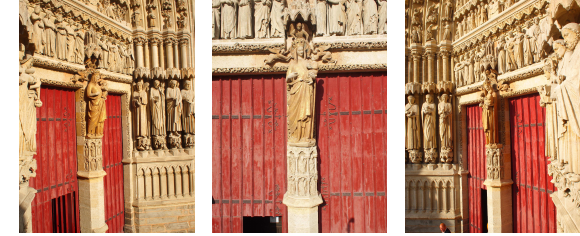
Figure 10: Images of the Virgin Mary used to the colorization (These digital images have a 4032x3024 pixels resolution) camera poses are estimated with the pose estimation presented before and we use our complete colorization process. Right now, the points colorization is done one image after the other. Points are projected in the first digital image, points covered by this one are colored and the others are labelled as not yet colored. Then, points are projected in a second digital image and only the cov- ered and labelled points are colorized. This operation is repeated with all the digital images or when all the points are colorized.